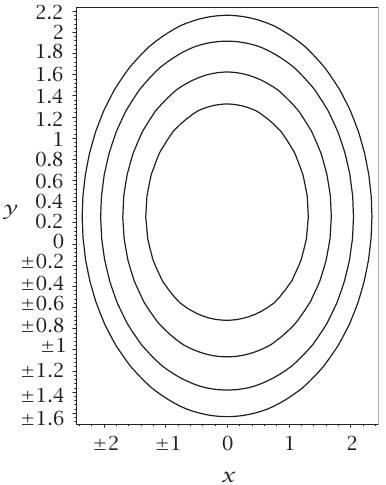
Figure 3.3 . Streamline pattern for 4 x 2 + 6 y 2 − 3 y − ln (x 2 + y 2 ) =